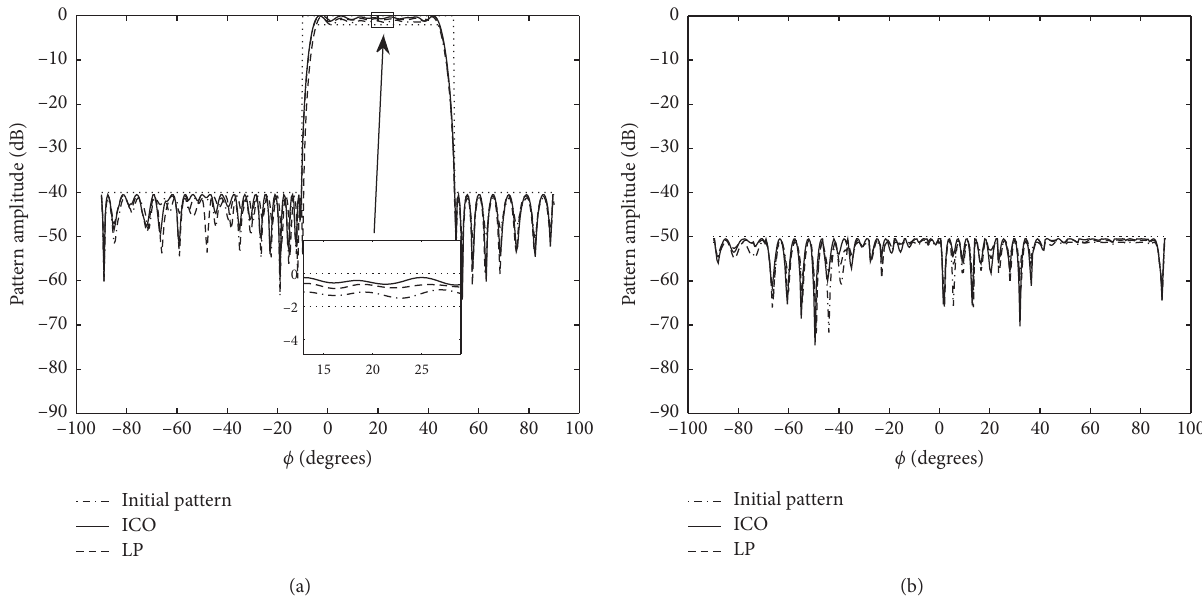
Figure 12: Flat-top-shaped beam synthesis of a 2 × 40-element array. (a) Copolarization component E at θ � 90 ∘ component E θ